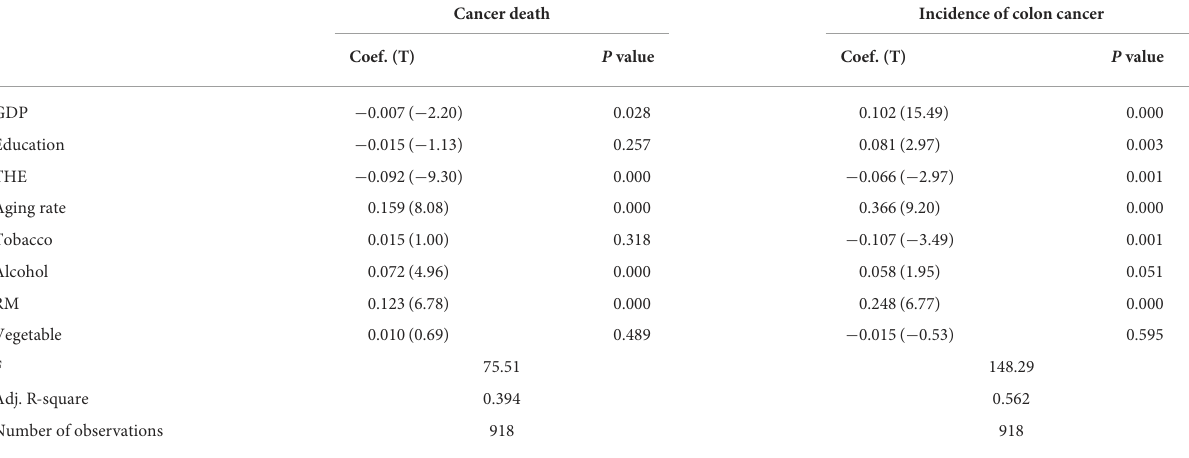
TABLE 3 Association between cancer death and incidence of colon cancer and each independent variable by pooled OLS analysis, 1989–2013.